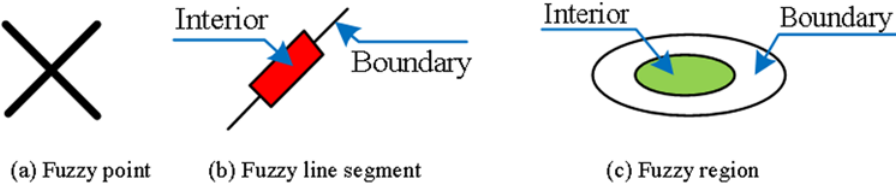
Fig 1. (a) Fuzzy point for given α ; (b) Fuzzy line segment for given β ; (c) Fuzzy region for given γ